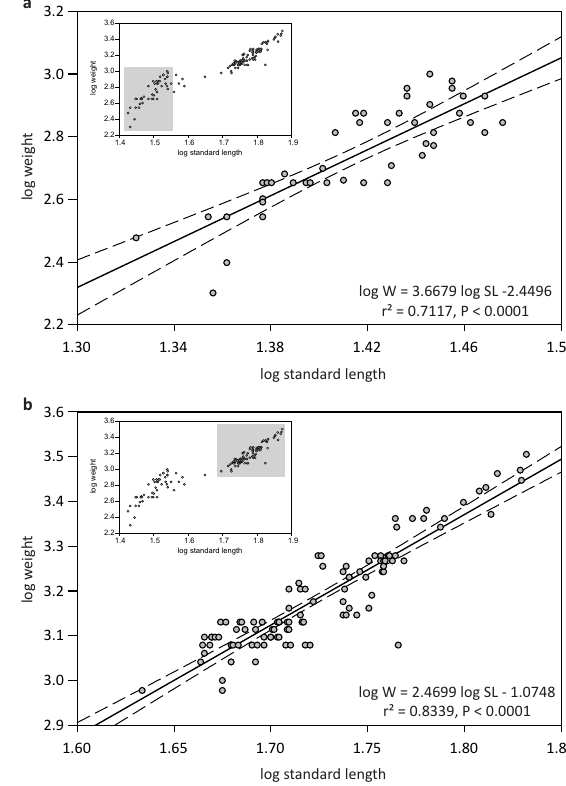
Figure 2. Standard length versus weight relationship of small (a) and large (b) specimens of Channa marulius . Length-weight data for all individuals combined (as in Fig. 2b) is given in the inset with the grey area indicating the subset of points used for the analysis. Dashed lines indicate 95% confidence interval for the regression